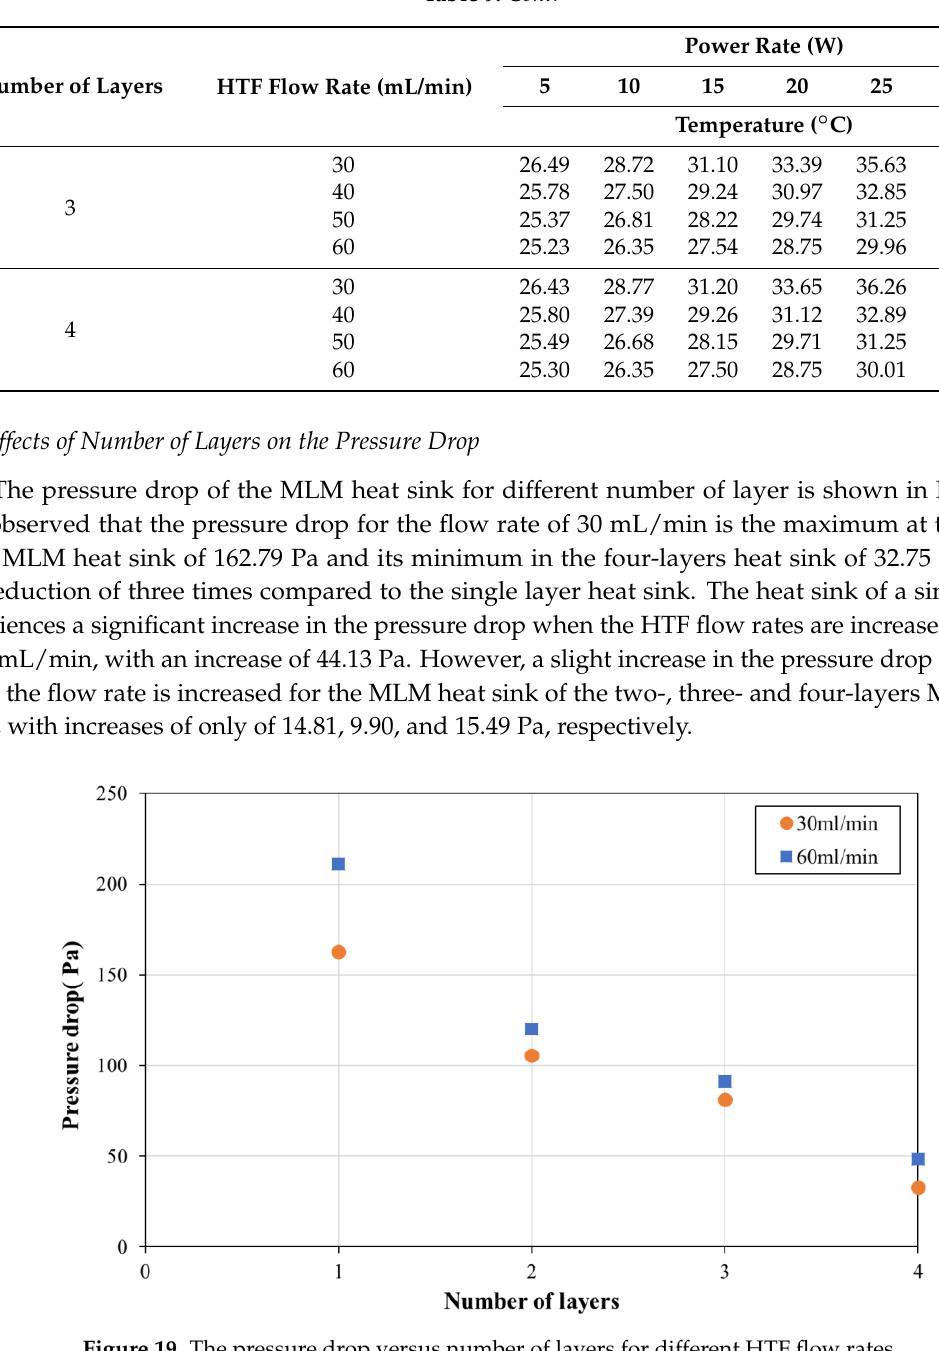
Figure 19. The pressure drop versus number of layers for different HTF flow rates.